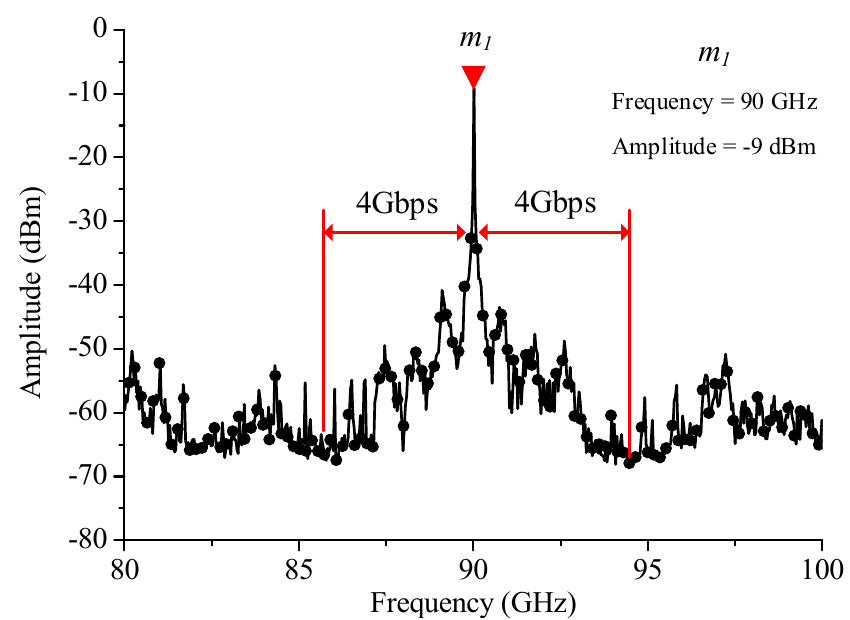
Figure 11. Measured output spectrum of RTD with OOK modulation.